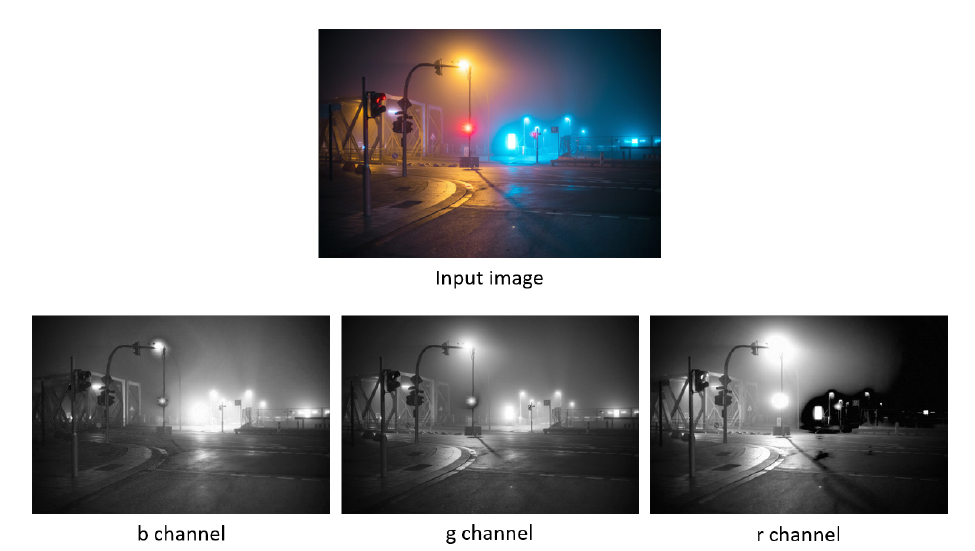
Figure 7. Nighttime foggy images. Reprinted with permission from ref. [35]. Copyright 2021 Mark Broyer.